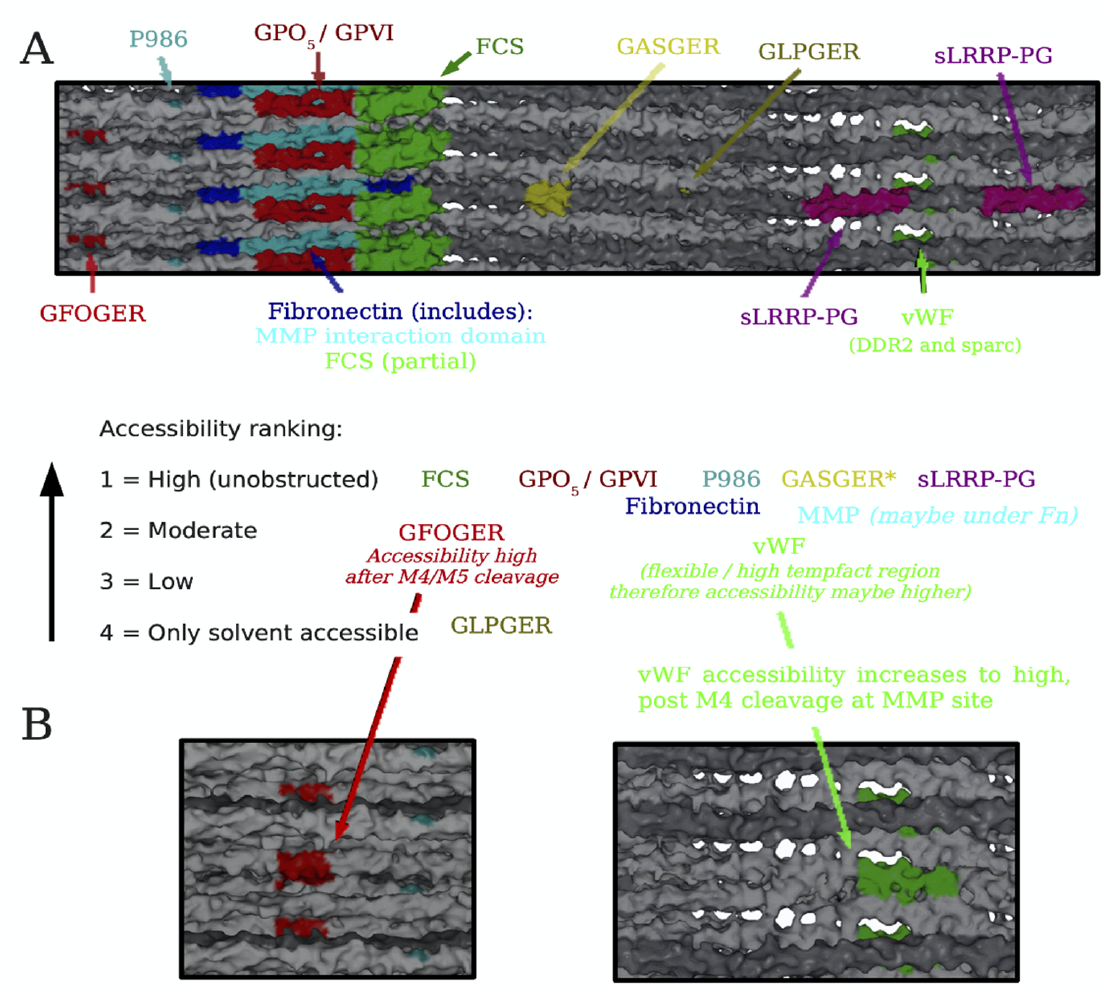
Figure 4. Ranking of ligand accessibilities to crucial binding sites and functional sequences in the native and proteolyzed type I collagen fibril. ( A ) Key functional domains of collagen were mapped onto a model of the fibril surface viewed from the fibril’s exterior. A molecular accessibility ranking of various ligands to their binding sites was determined for the static fibril, and following MMP-1 cleavage of M4 and “opening up” of the fibril. ( B ) View of the fibril’s GFOGER and Von Willebrand’s Factor (vWF)-binding sites following MMP-1 cleavage of M4. Reprinted with permission from